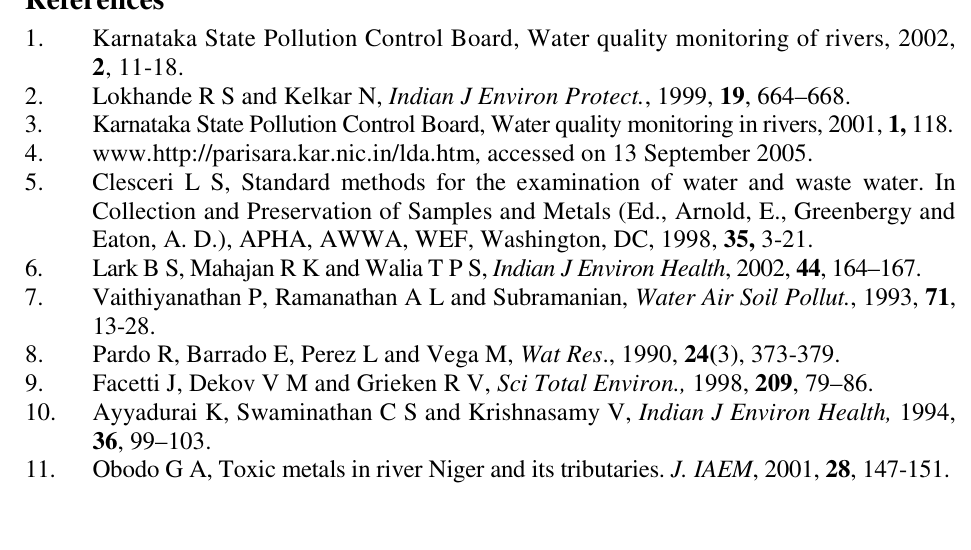
Sampling stations Heavy